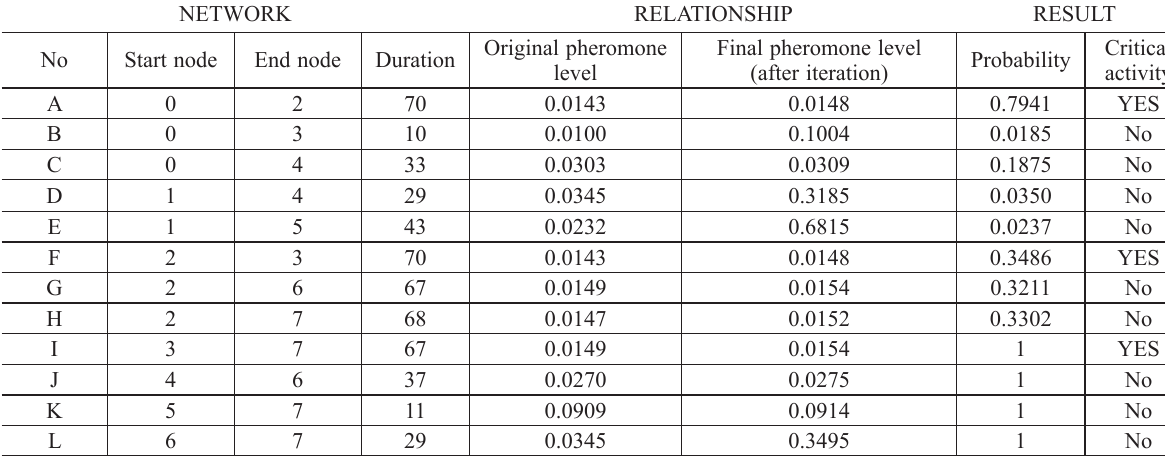
Table 8. Solution of Critical Path using